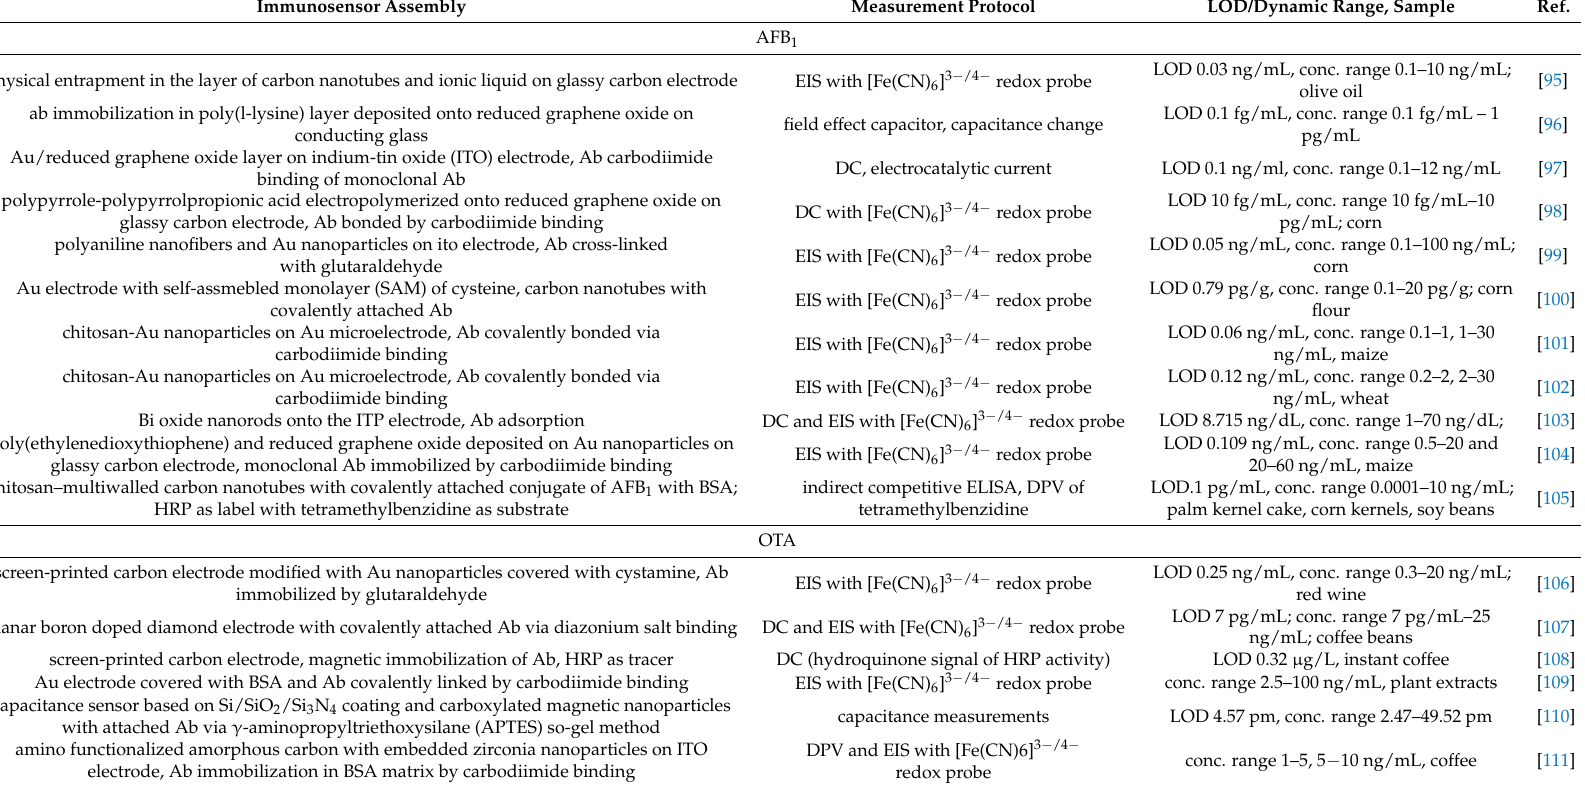
Table 2. Analytical characteristics of immunosensors for mycotoxin determination